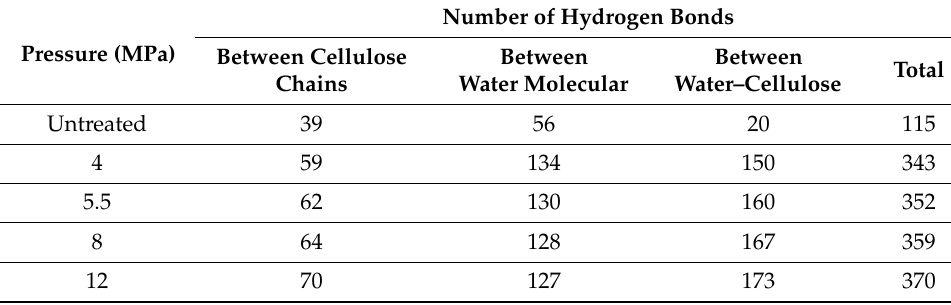
Number of Hydrogen